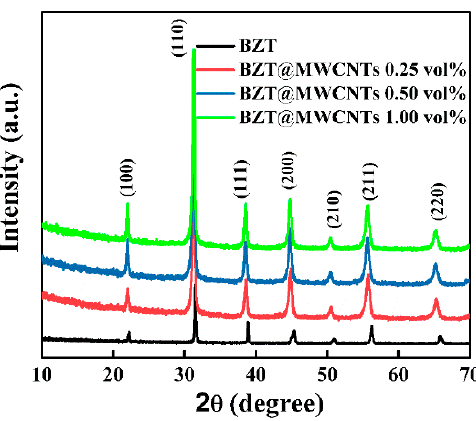
Figure 2. XRD patterns of BZT@MWCNTs nanoparticles with different MWCNTs contents.